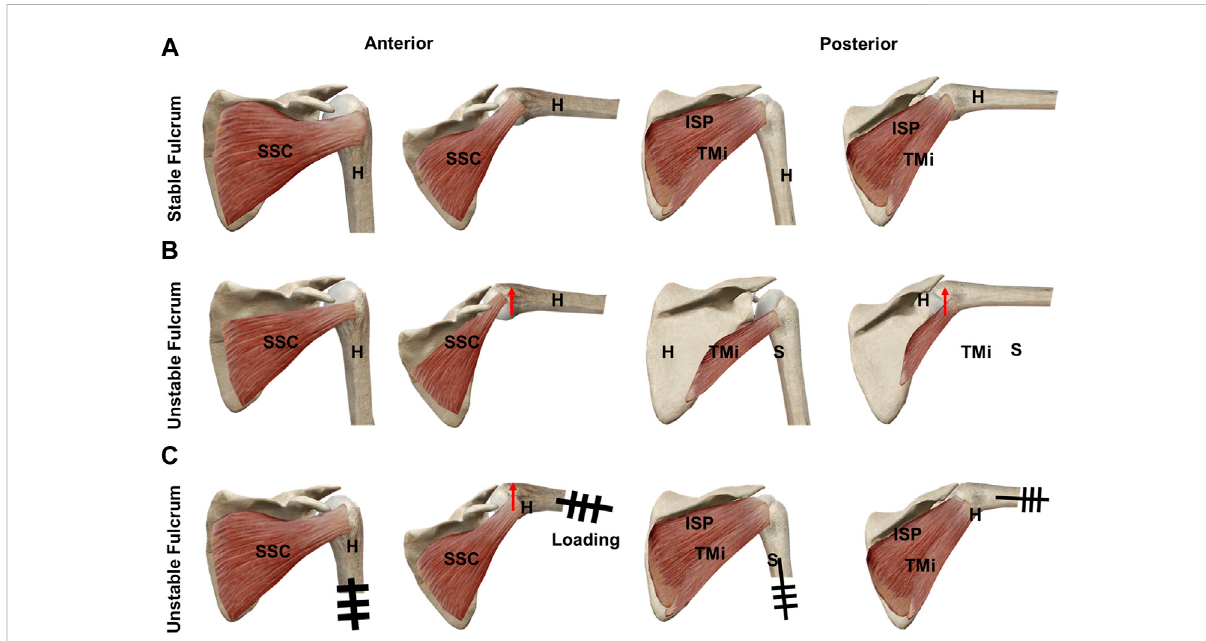
FIGURE 7 Schematic graphs of the superior migration of the humeral head and fulcrum during abduction: (A) RCT with remnant rotator cuff tissue above the equatorial line of the humeral head at 0 ° and 60 ° glenohumeral abduction, (B) 0 ° and 60 ° glenohumeral abduction of MRCT without remnant rotatorcufftissueabovetheequatoriallineofthehumeralhead,and (C) RCTwithremnantrotatorcufftissueabovetheequatoriallineofthehumeral head with extra loading at 0 ° and 60 ° glenohumeral abduction. H: humerus; ISP: infraspinatus; RCT: rotator cuff tear; S: scapular; SSC: subscapularis; TMi: teres